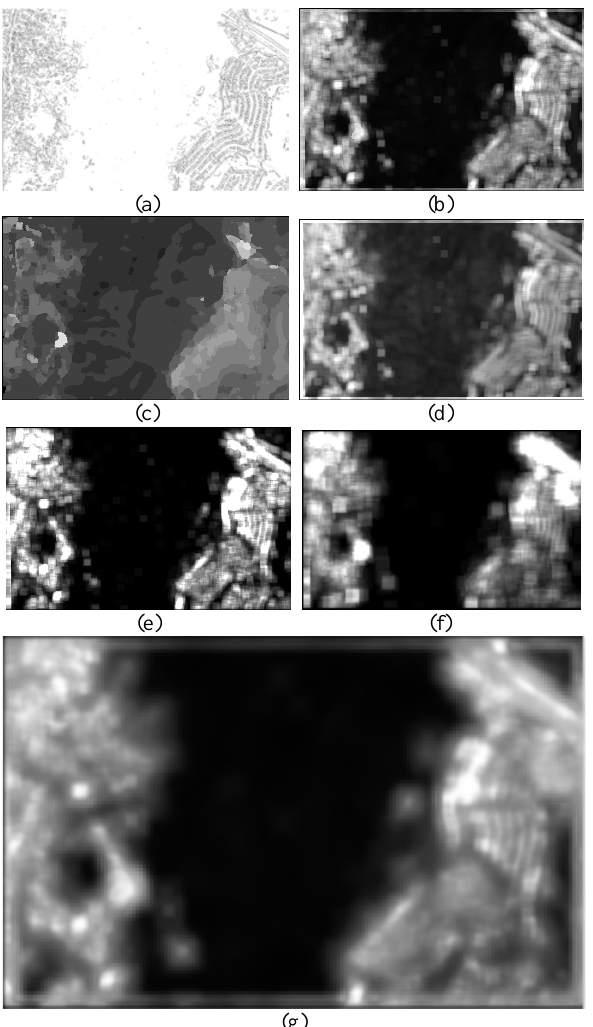
Fig. 6 the final visual saliency image of artificial areas